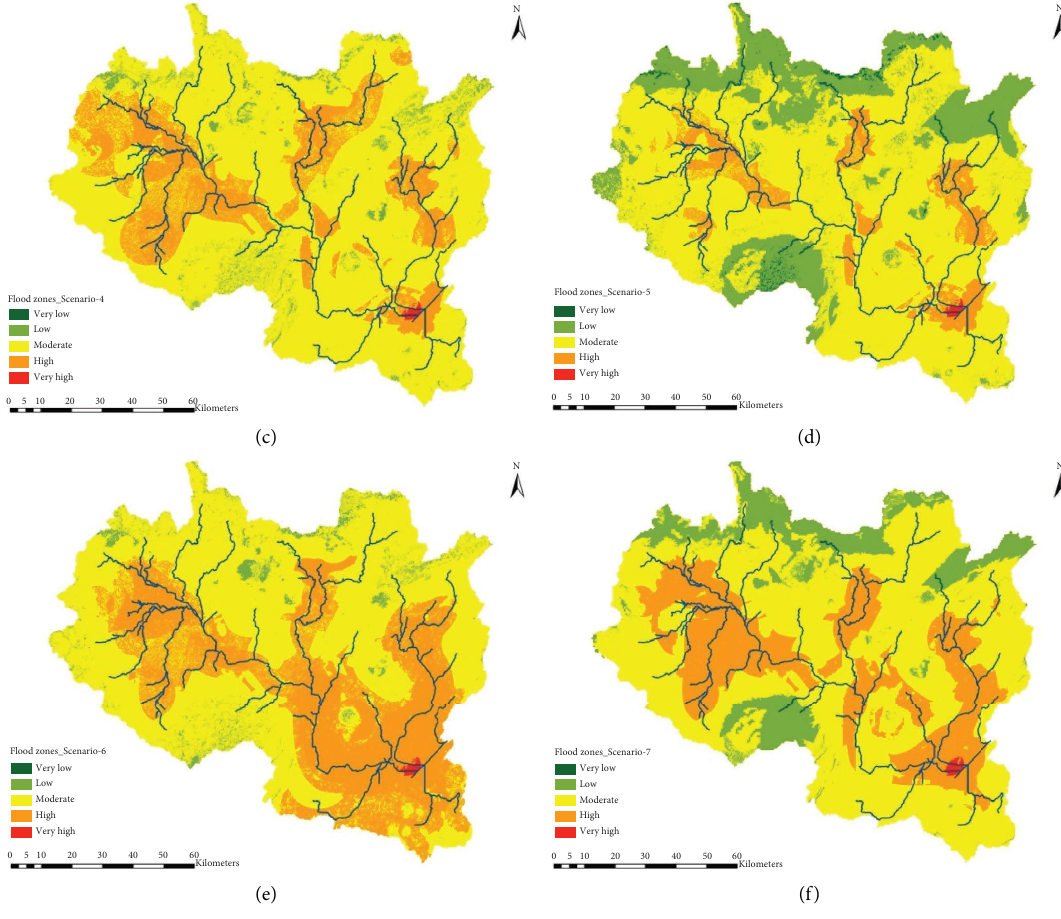
Figure 6: Flood hazard index maps of diferent scenarios.